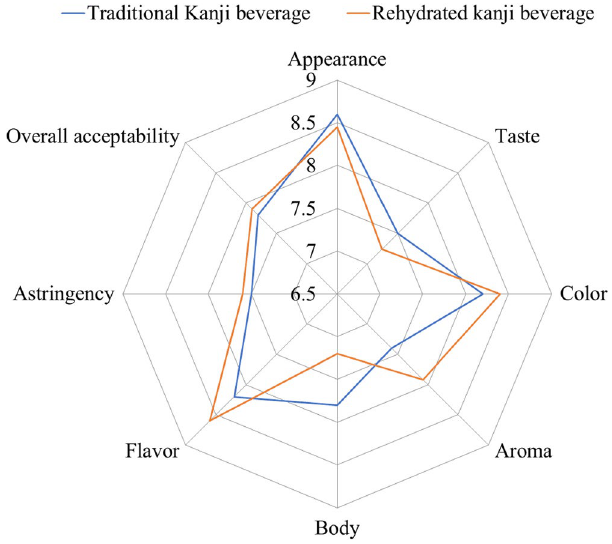
Figure 3. Overall acceptance score of traditional Kanji beverage and LAB fermentation of Kanji beverage reconstituted at 10:60